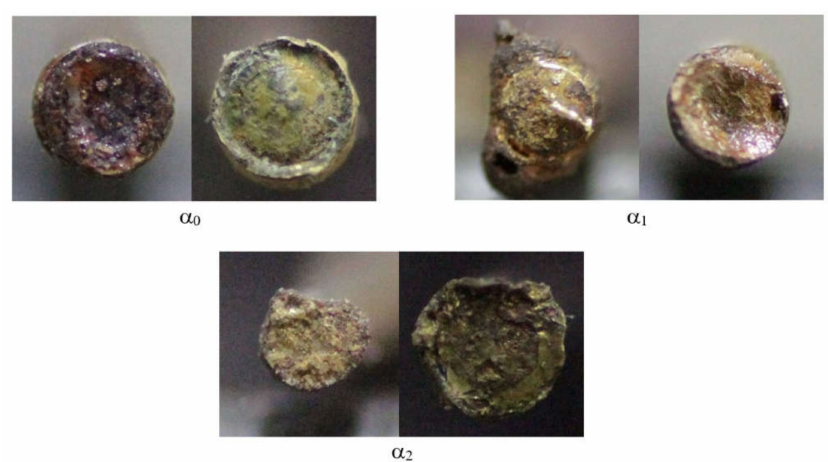
Figure 4. The fracture surface of the CDW welding joints after being exposed to the SCC